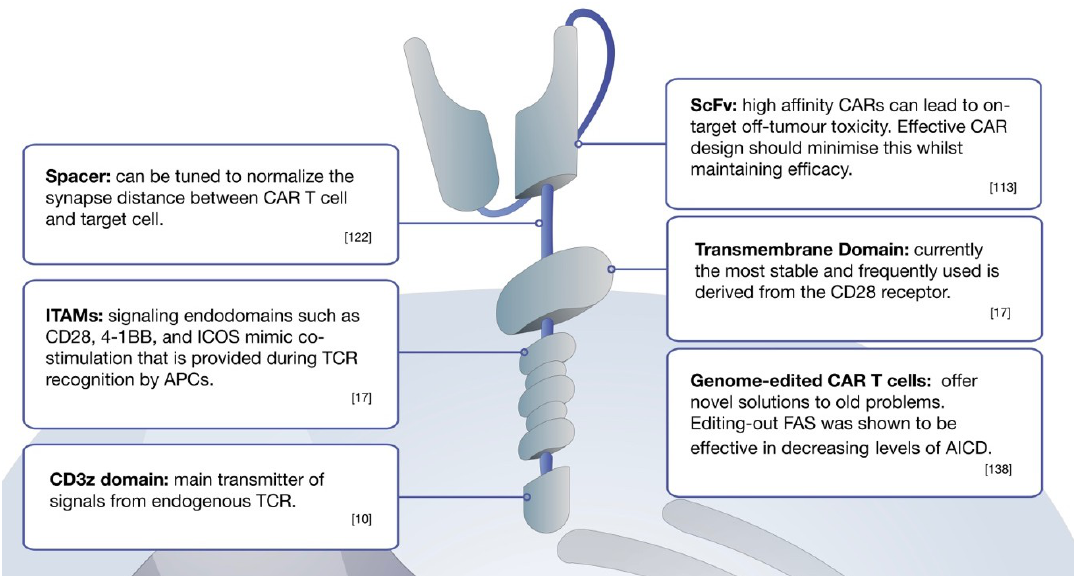
Figure 1. A chimeric antigen receptor (CAR) is composed of several components, each of which contributes towards the proper activation, functionality, and persistence of CAR T cells. In addition to the CAR, T cell gene editing approaches can also augment functional